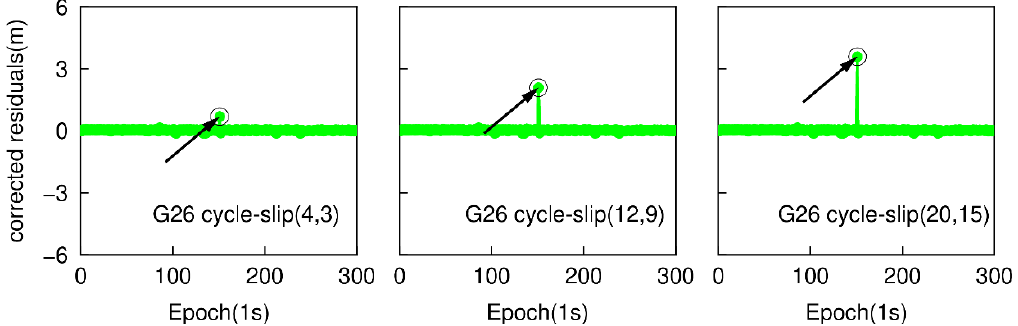
Figure 13. Specific small cycle-slip combination detection results by checking the largest residual for G26. Sensors 2020 , 20 , x FOR PEER REVIEW